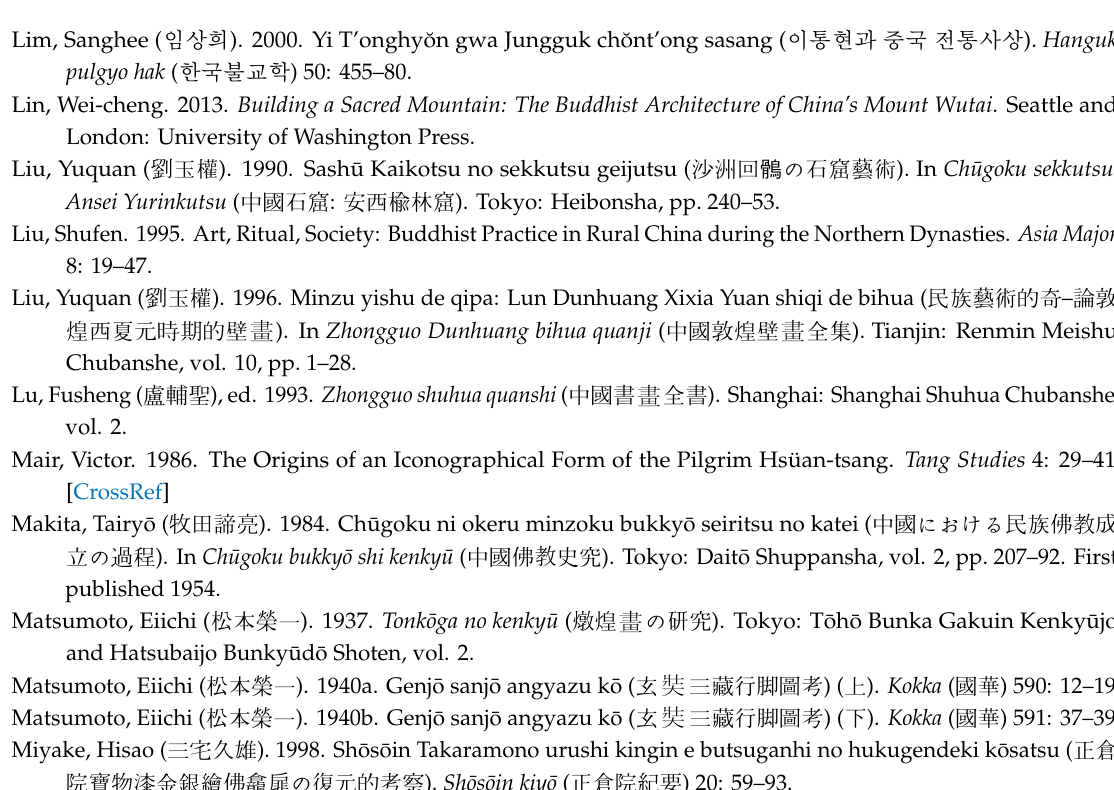
Figure 7. Itinerant Monk . Dunhuang, 10th century. Ink and colors on paper, 51.8 × 29. 3 cm. Inv.